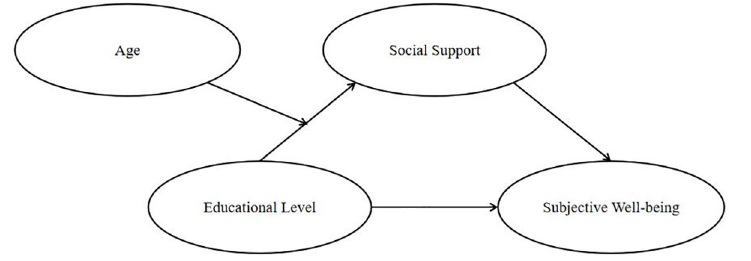
Fig 1. The proposed moderated mediation